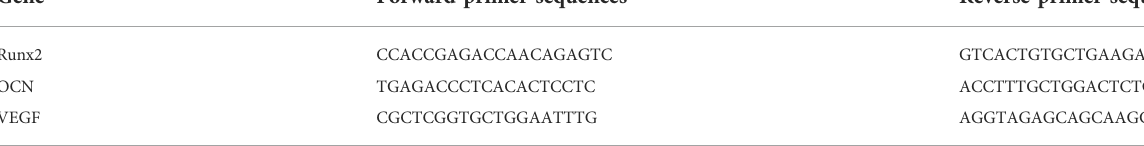
TABLE 1 The forward and reverse sequences of the primers.